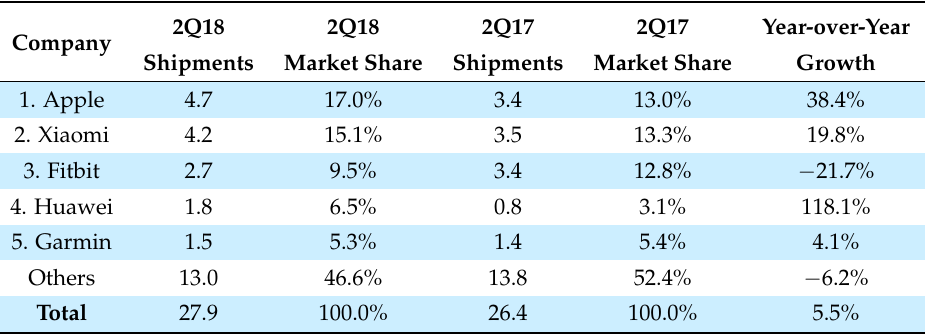
Table 4. Top 5 worldwide wearable device companies, shipments (in millions), market share and year-over-year growth, Q2